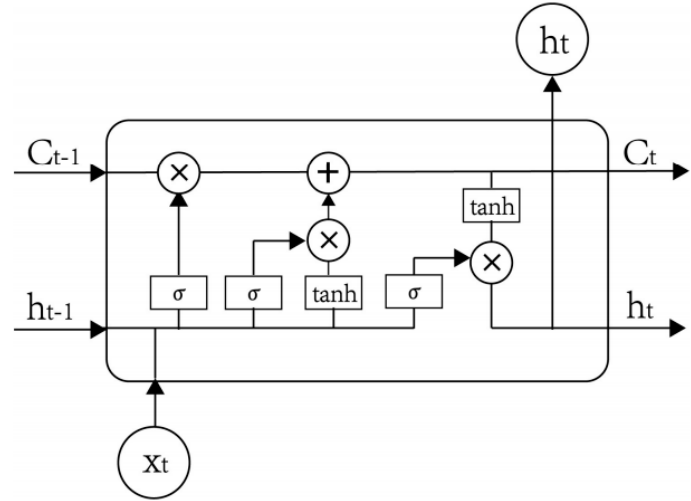
Figure 2. The diagram of an LSTM memory cell at the time step t .